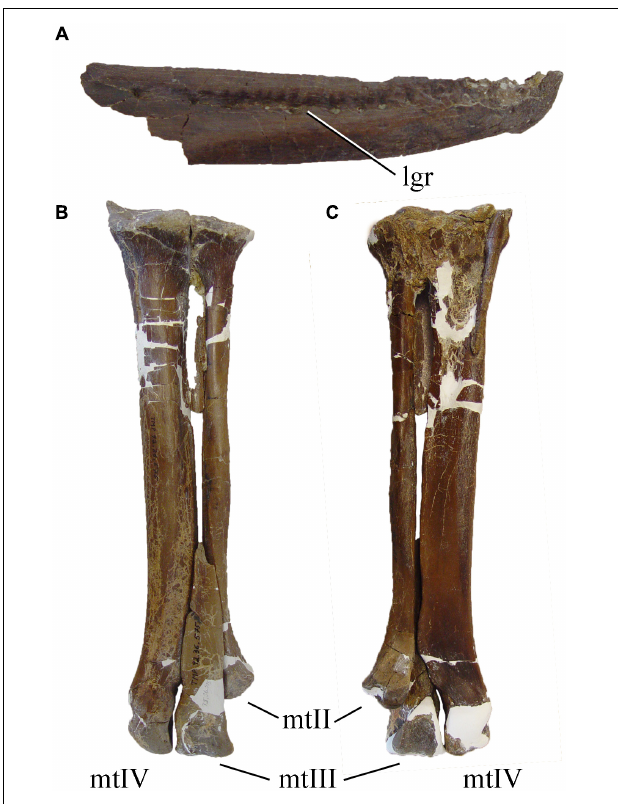
FIGURE 3 | Selected troodontid traits: (A) right dentary (CMN 12340) of Latenivenatrix mcmasterae in lateral view, showing the longitudinal dentary groove; (B,C) left metatarsus of Latenivenatrix mcmasterae (CMN 12340) in (B) dorsal, and (C) lateral views, showing the size difference between metatarsal IV and metatarsal II. Not to